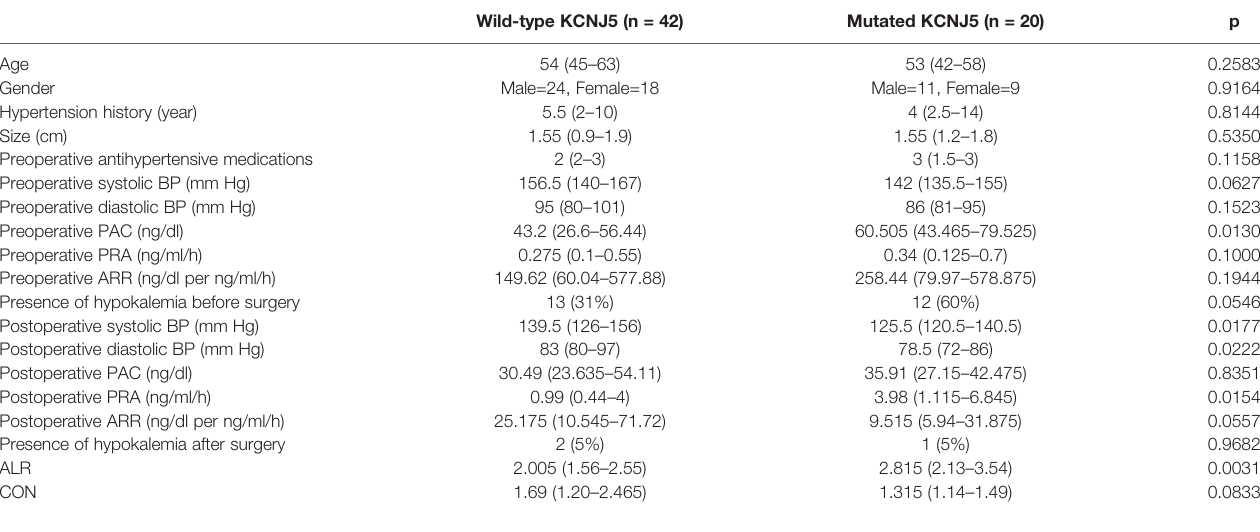
TABLE 1 | Association between patients ’ characteristics and KCNJ5